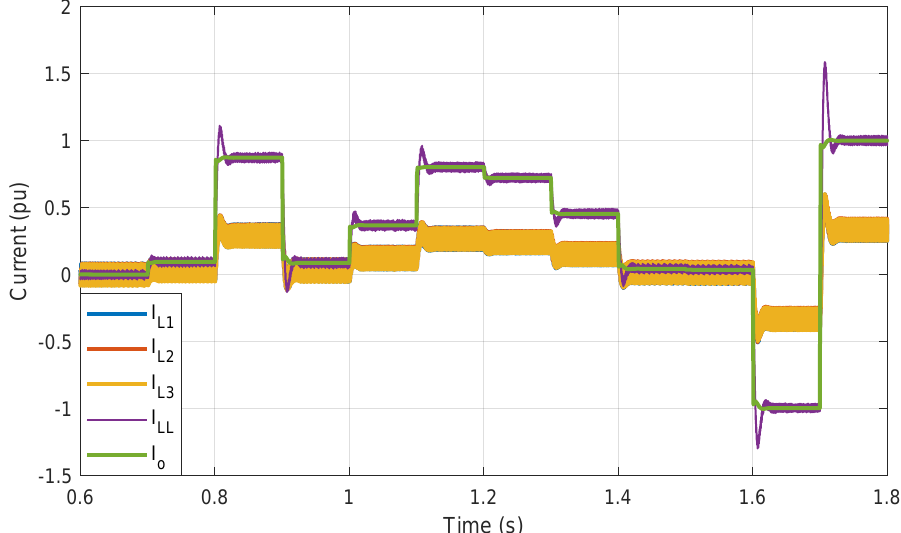
Figure 14. DC microgrid operating with bidirectional power flow and with different levels of load and generation connection resulting in different power steps imposed on the DC microgrid. In this figure, the phase currents ( i La , i Lb and i Lc ) , the reduced-ripple output current ( i LL ) and the load current ( i o ) are shown.